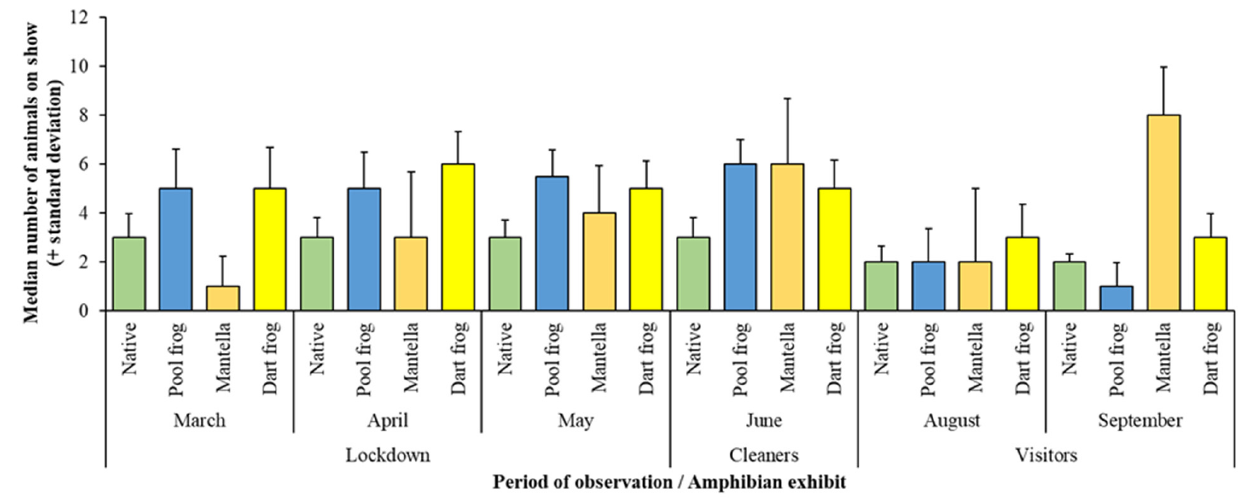
Figure 1. The median number of animals from each exhibit under observation for each of the three study periods (lockdown, when cleaning staff returned, and when visitors returned). Decreases in median number of animals on show is noted for all exhibits except for the Golden Mantella Exhibit.